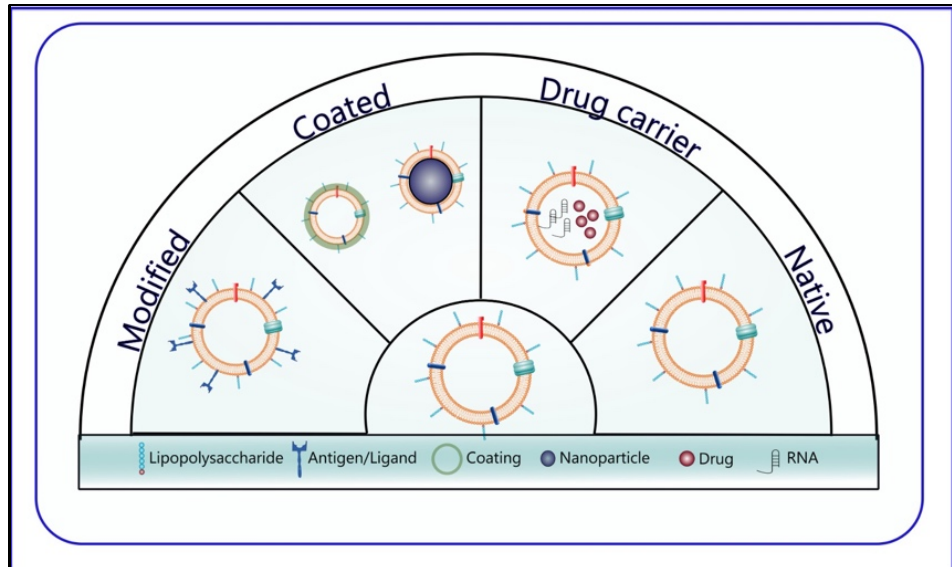
Figure 4. Di ff erent OMV approaches used in cancer therapy. Figure 4. Different OMV approaches used in cancer